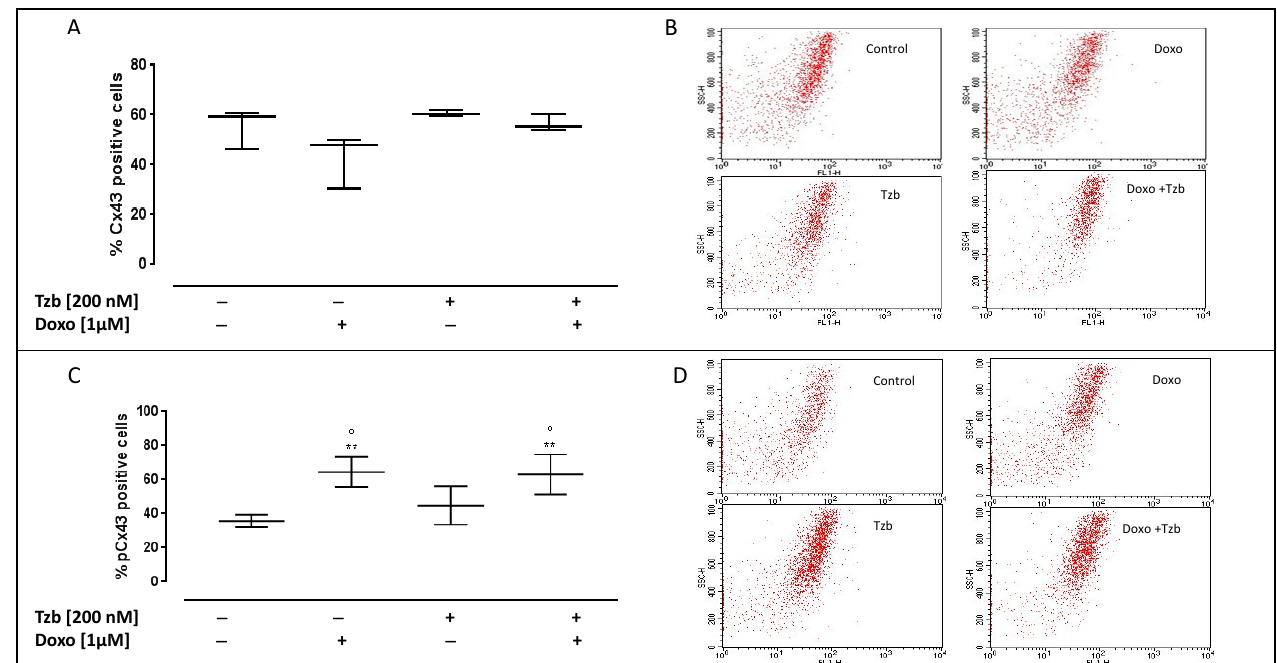
Figure 5. Doxo and Tzb and their association effect on Cx43 and pCx43 expression. Doxo (1 µ M) was administered for 4 h, and Tzb (200 nM) was administered for 20 h. Cx43 and pCx43 expression was checked through flow cytometry analysis. Results are expressed as mean ± S.E.M. of percentage of Cx43 ( A ) and pCx43 ( C ) positive cells from at least three independent experiments, each performed in duplicate. Data were analysed by variance test analysis, and multiple comparisons were made by Bonferroni’s test. ** p < 0.005 vs. non-treated cells, ◦ p < 0.005 vs. Tzb-treated cells. Panels ( B , D ) report representative images of flow cytometry analysis of Cx43 and pCx43 expression,